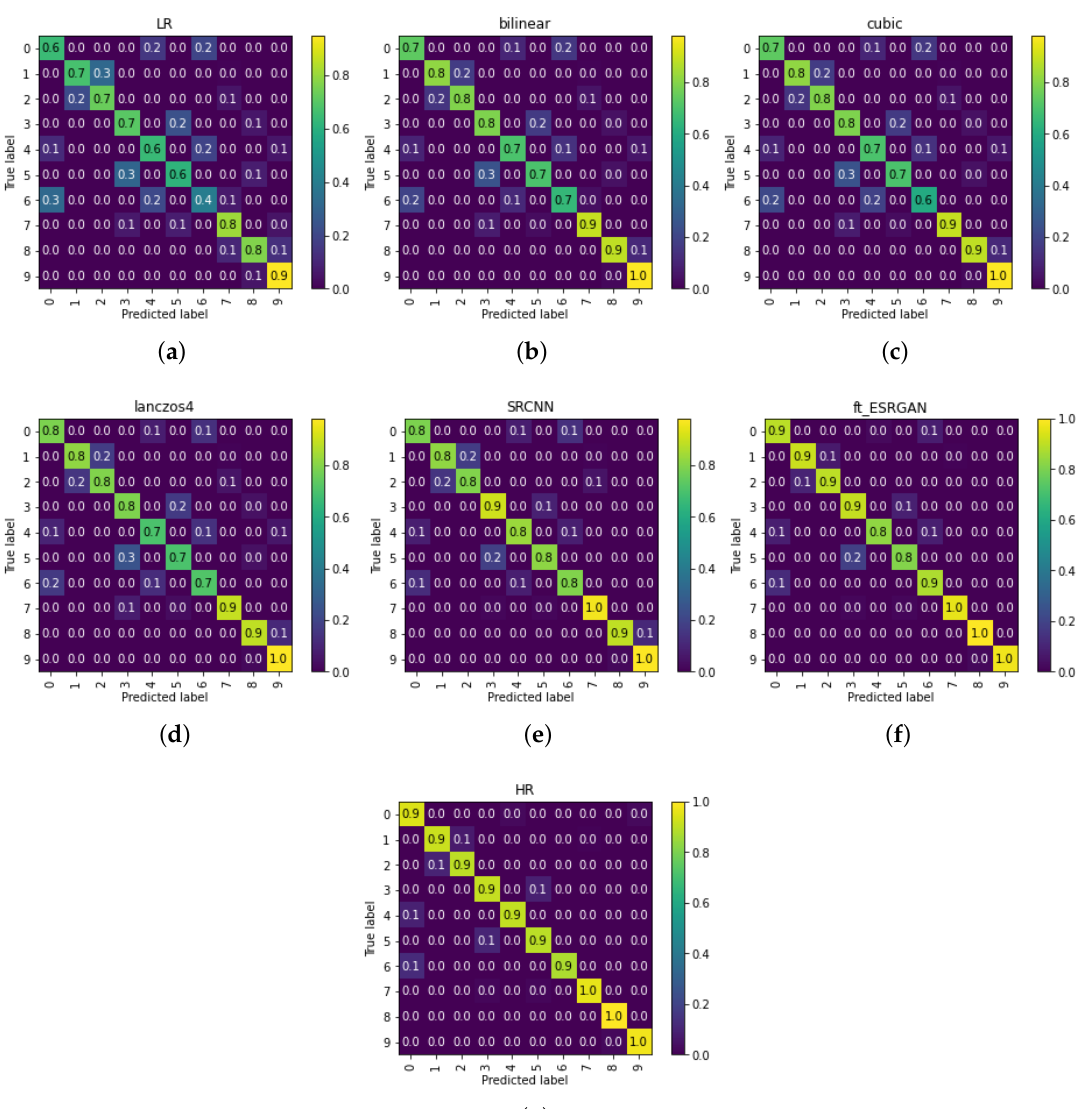
Figure 8. Confusion matrix of disease classification using using LR (32 × 32 pixels), SR (128 × 128 pixels) and HR images (128 × 128 pixels). Numbers on x and y axes indicate the ID of diseases in Table 1. ( a ) LR; ( b ) Bilinear; ( c ) Cubic; ( d ) Lanczos4; ( e ) SRCNN; ( f ) ft_ESRGAN; ( g )